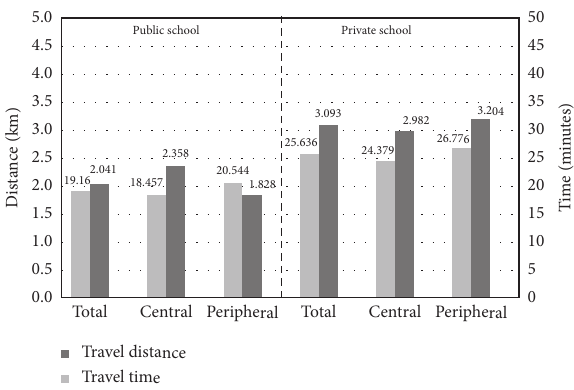
Figure 4: School commuting distance and duration by school type.